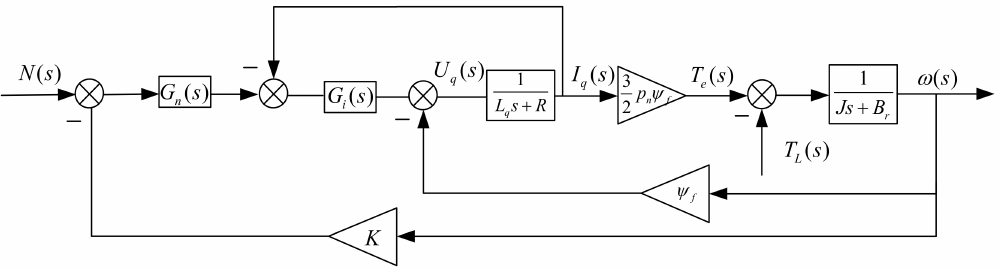
Figure 3. Diagram of AC servo